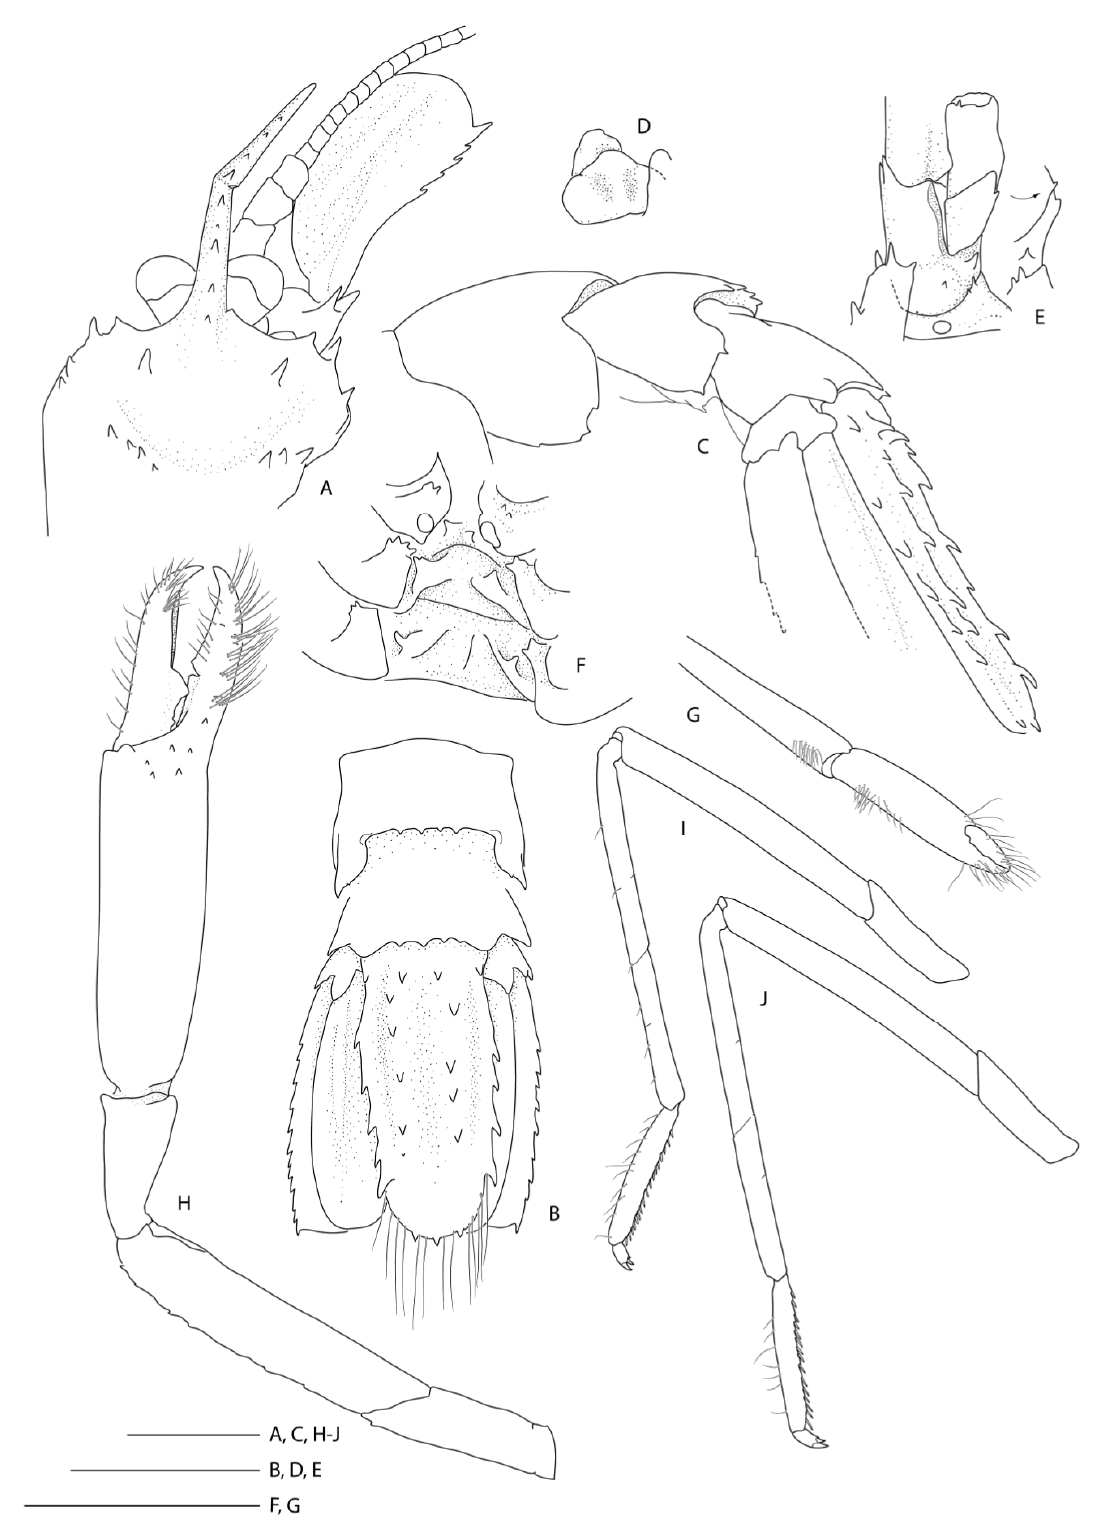
Figure 23. Spongicaris yaldwyni Bruce & Baba, 1973 [21], holotype F (NMNZ CR.001888). ( A ) Anterior carapace and cephalic appendages, dorsal. ( B ) Pleonites 5 and 6, urosome and telson, dorsal. ( C ) Pleonites 4–6, urosome and telson, lateral. ( D ) Epistome and labrum, oblique ventral view. ( E ) Right antenna, ventral with detail of rotated mesial margin of basicerite. ( F ) Thoracic sternites 6–8 with coxae of pereiopods, ventral. ( G ) Left distal portion of P1, mesial. ( H ) Right P1, lateral. ( I , J ) Lose P4 or P5, lateral. Scale bars = 2